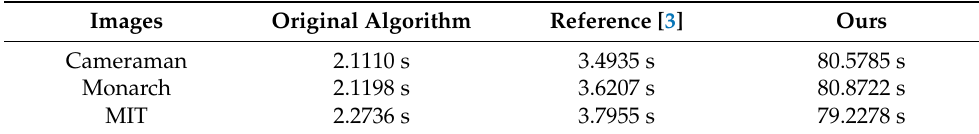
Table 10. Running time of the three